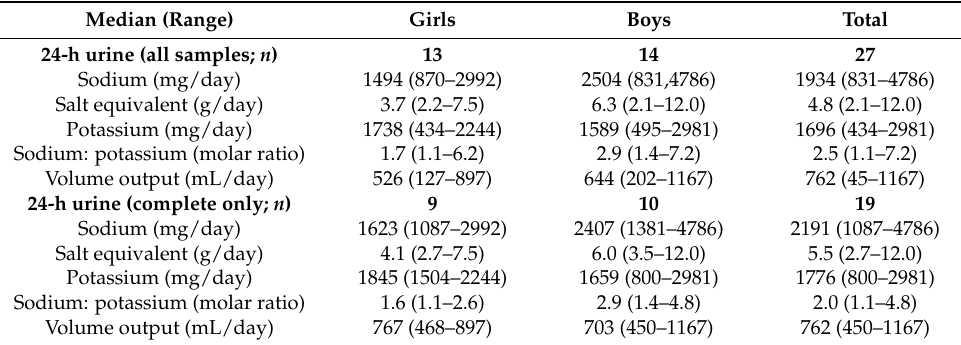
Table 2. Twenty four hour urinary electrolyte excretion overall and by